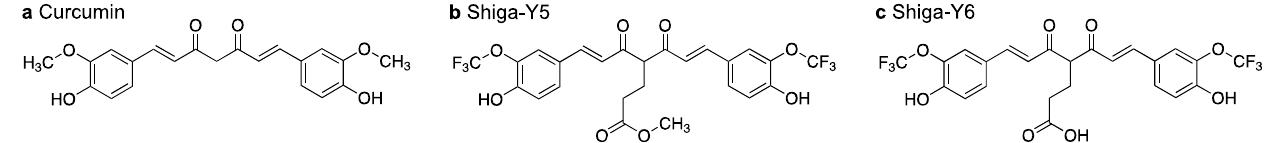
Figure 1. Chemical structure of curcumin, Shiga-Y5 and Shiga-Y6. ( a ) Curcumin, a yellow–orange pigment in turmeric. ( b ) Shiga-Y5 is a fluorinated curcumin derivative with methyl ester groups at the C-4 position. ( c ) Shiga-Y6 with carbonic acid groups at the C-4 position was obtained by the hydrolysis of Shiga-Y5.